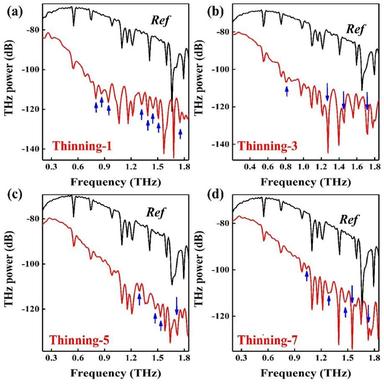
THz-FDS analysis of air (Ref.) and the polished oil shale samples. (a)e(d) THz-FDS of polished oil shale strips 1, 3, 5, and 7.